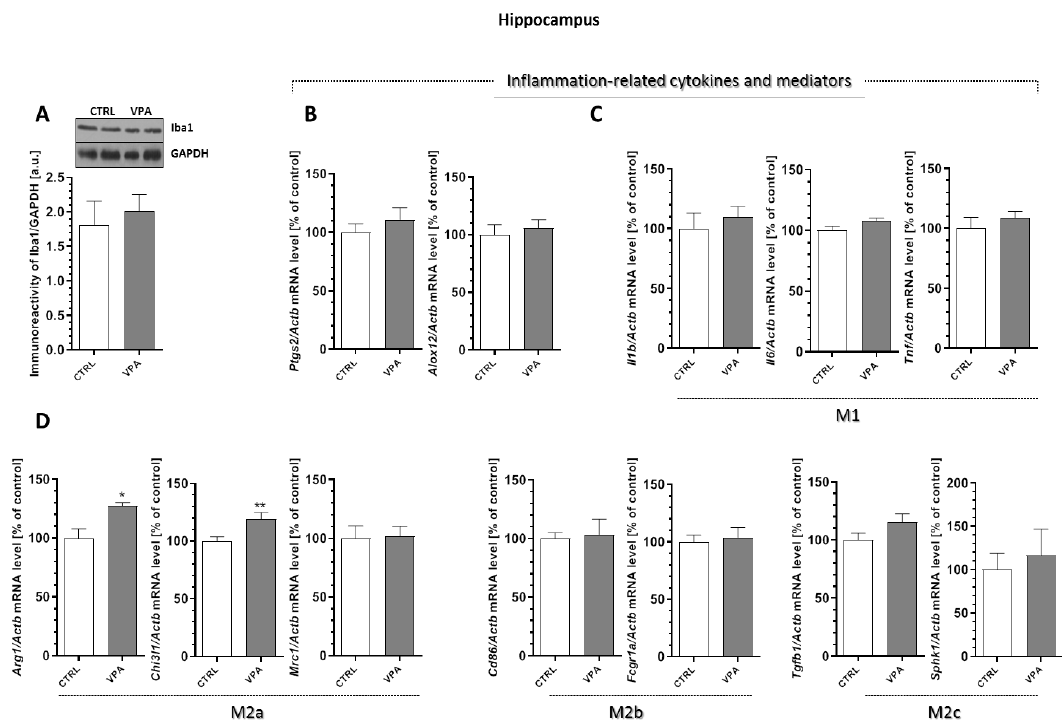
Figure 9. The e ff ect of prenatal exposure to VPA on the status of microglia in the hippocampus. ( A ) The immunoreactivity of Iba-1 was monitored using a Western blot analysis. Densitometric analysis and representative pictures are shown. Results were normalized to GAPDH levels. Data represent the mean values ± SEM from n = (6–8). independent experiments. The gene expression of Ptgs2 , Alox12, ( B ); Il1b, Il6, and Tnf ( C ); and the markers of the M2 phenotype’s microglia activation: Arg1, Chi3l1, Mrc1, Cd86, Fcgr1a, Tgfb1, and Sphk1 ( D ), in the hippocampus of the control and VPA-exposed rats were measured with quantitative RT-PCR and calculated by the ∆∆ Ct method using Actb ( β -actin) as a reference gene. Data represent the mean values ± SEM from n = (4–6) independent experiments. * p < 0.5, ** p < 0.01 vs. control.